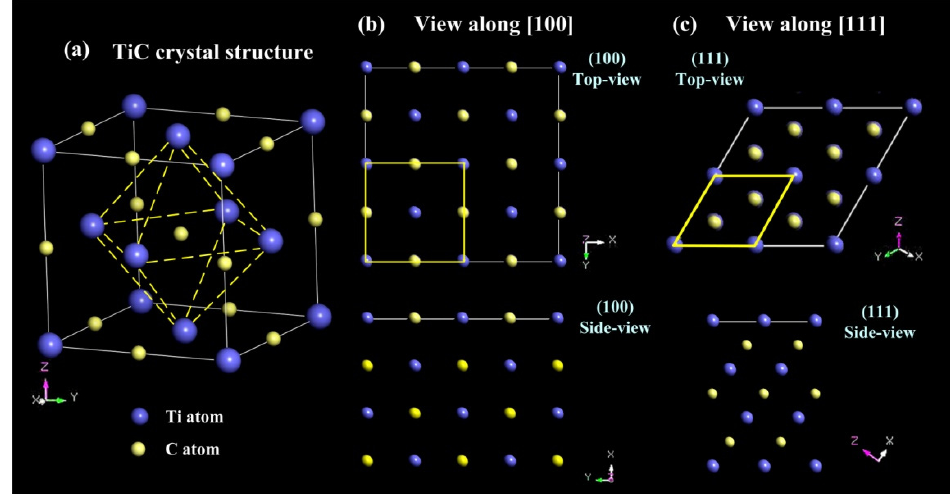
Figure 3. ( a ) The crystal structure of TiC; ( b ) The TiC crystal structure view along [100]; ( c ) The TiC crystal structure view along [111];.